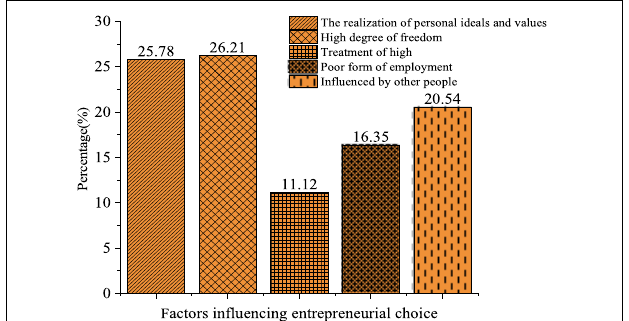
FIGURE 1 | Factors influencing the entrepreneurial choice.